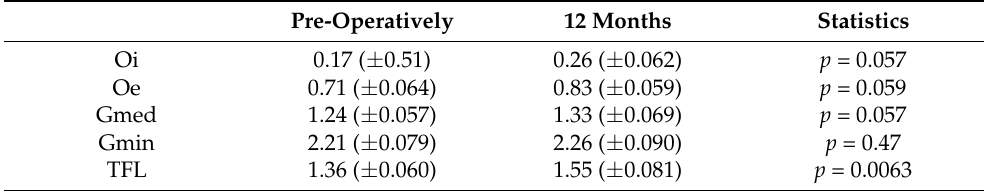
Table 4. Fatty atrophy grade of each muscle pre-operatively, 12 months